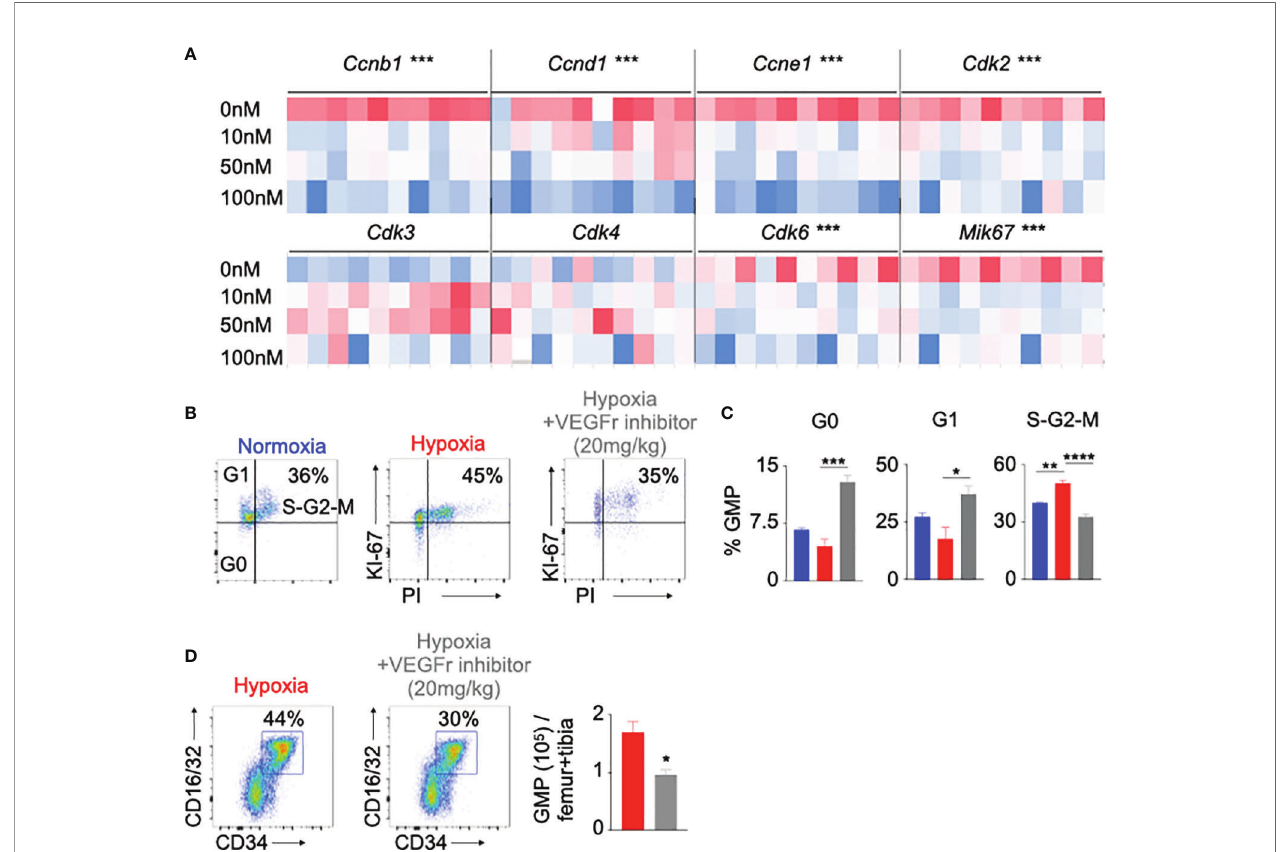
FIGURE 4 | Vegfr inhibition decreased hematopoietic progenitor proliferation in hypoxia. (A) Heatmap depicting expression of the cell cycle genes in mouse HSPC treated with increasing amounts of a Vegfr inhibitor (SU5416, 10-100nM) or vehicle. (B-D) C57BL/6 mice were treated with either SU5416 or vehicle diluent and placed in either normoxia or hypoxia for 21 days. Bone marrow cells were analyzed using fl ow cytometry to assess GMP proliferation (B, C) and number (D) . n = 5 replicates or mice per condition. Data are shown as mean ± s.e.m. *P < 0.05, **P <. 0.01, ***P < 0.001, ****P <